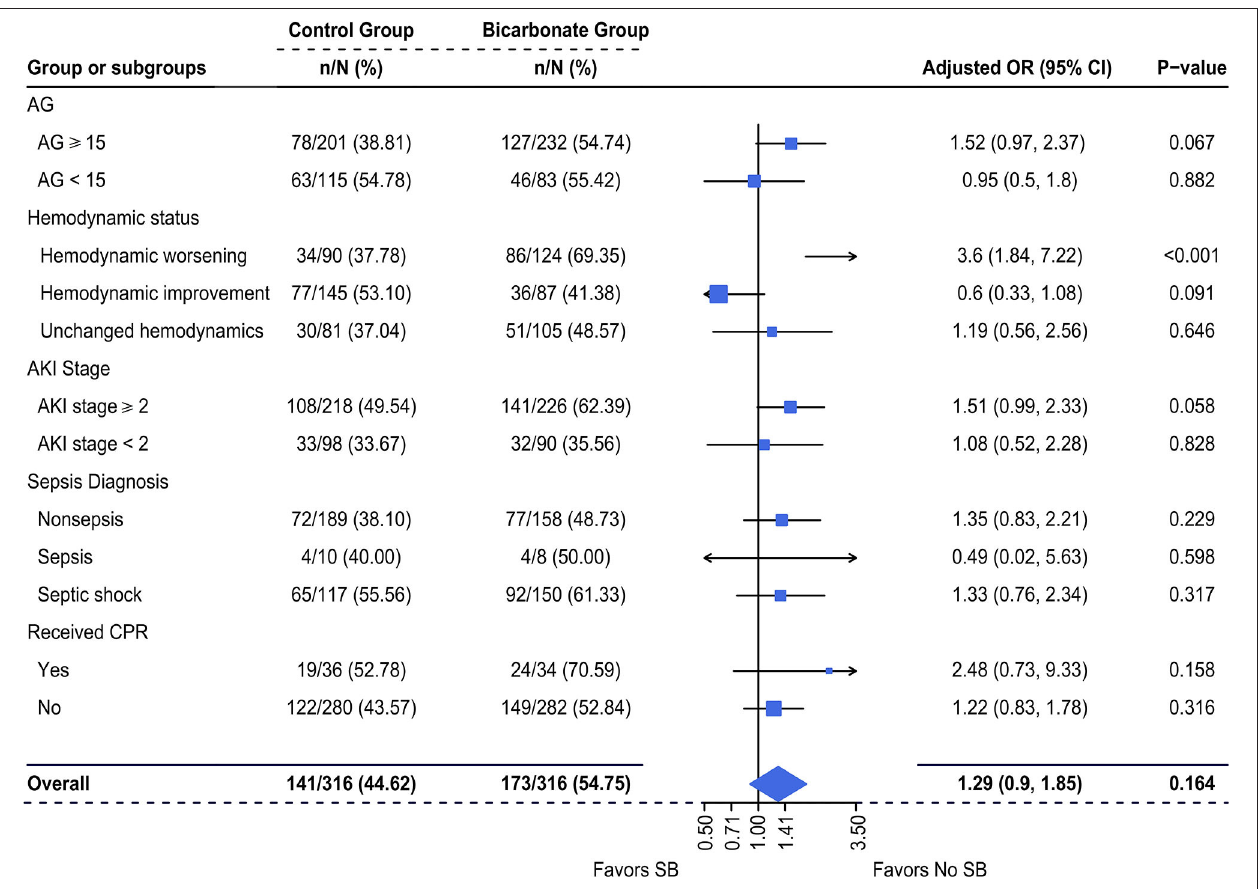
FIGURE 3 | Multivariable-adjusted odds ratios of SBT for newly d/eOD. Multiple logistic regression was used. We adjusted for variables including (1) mechanical ventilation within 48h after ICU admission, (2) sepsis diagnosis, (3) ketoacidosis diagnosis, (4) CPR, (5) cumulative fluid balance within 48h after ICU admission, (6) SOFA score during the first 24h after ICU admission and (7) pH-value. d/eOD, developed or exacerbated organ dysfunction; AKI, acute kidney injury; AG, anion gap; CPR, cardiopulmonary